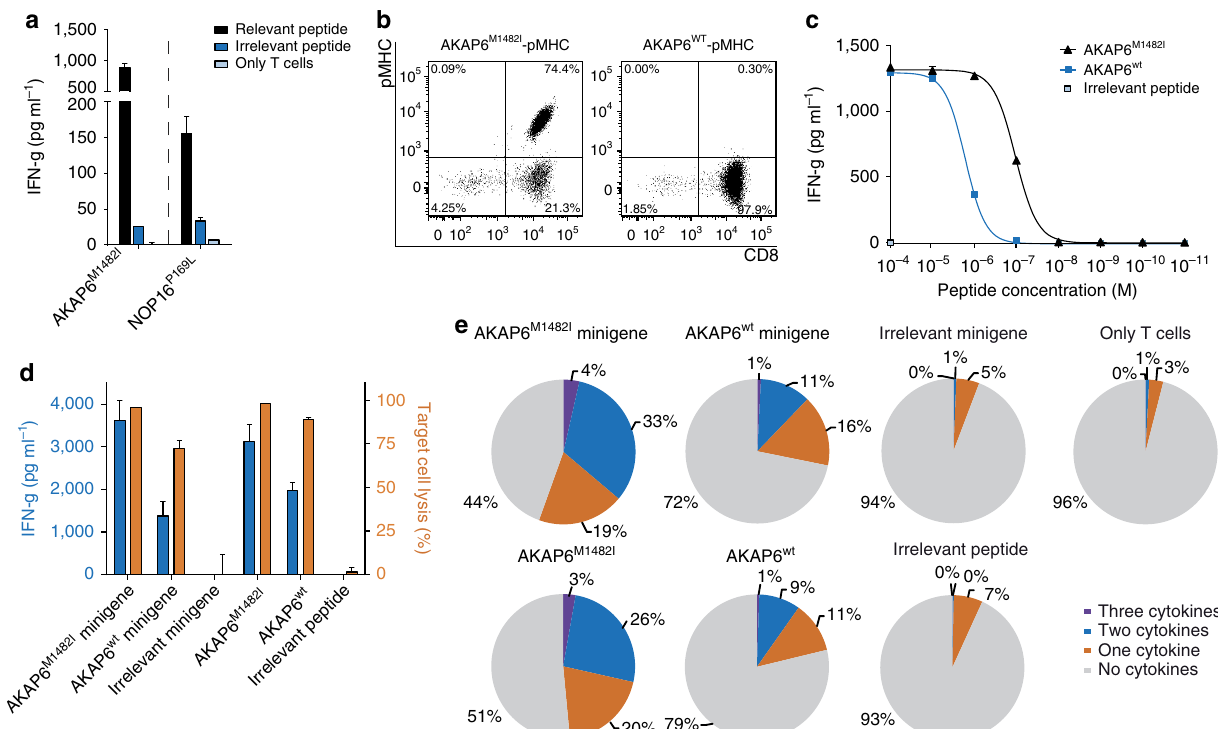
Figure 7 | Characterization of mutant-specific T-cell responses in HLA-matched healthy donors. T-cell responses of two different matched healthy donors against neoepitopes AKAP6 M1482I and NOP16 P169L . Effector cells were coincubated in duplicates with T2-A3 or T2-B7 pulsed either with the relevant peptide or control peptides with the same HLA restriction as the mutated ligands, results are shown as mean ( a ). Staining of T-cell line HD1- AKAP6 with the mutated or wt multimer ( b ). IFN-g release of the T-cell line on peptide titration of AKAP6 M1482I and its non-mutated counterpart using T2- A3 as targets (duplicates are depicted as mean) ( c ). IFN-g secretion (left Y-axis) and target-cell lysis (right Y -axis) after coincubation of the T-cell line HD1- AKAP6 with peptide-pulsed and minigene-transduced LCL1 cells performed in triplicates, data shown as mean ± s.d. ( d ). Intracellular cytokine staining (IFN-g, TNF-a and IL-2) on co-culture of the T-cell line HD1-AKAP6 with LCL1 cells, either peptide-pulsed or minigene-transduced, determined by flow cytometry. Cells were gated on ethidium monoazide bromide-negative and CD8-positive events ( e